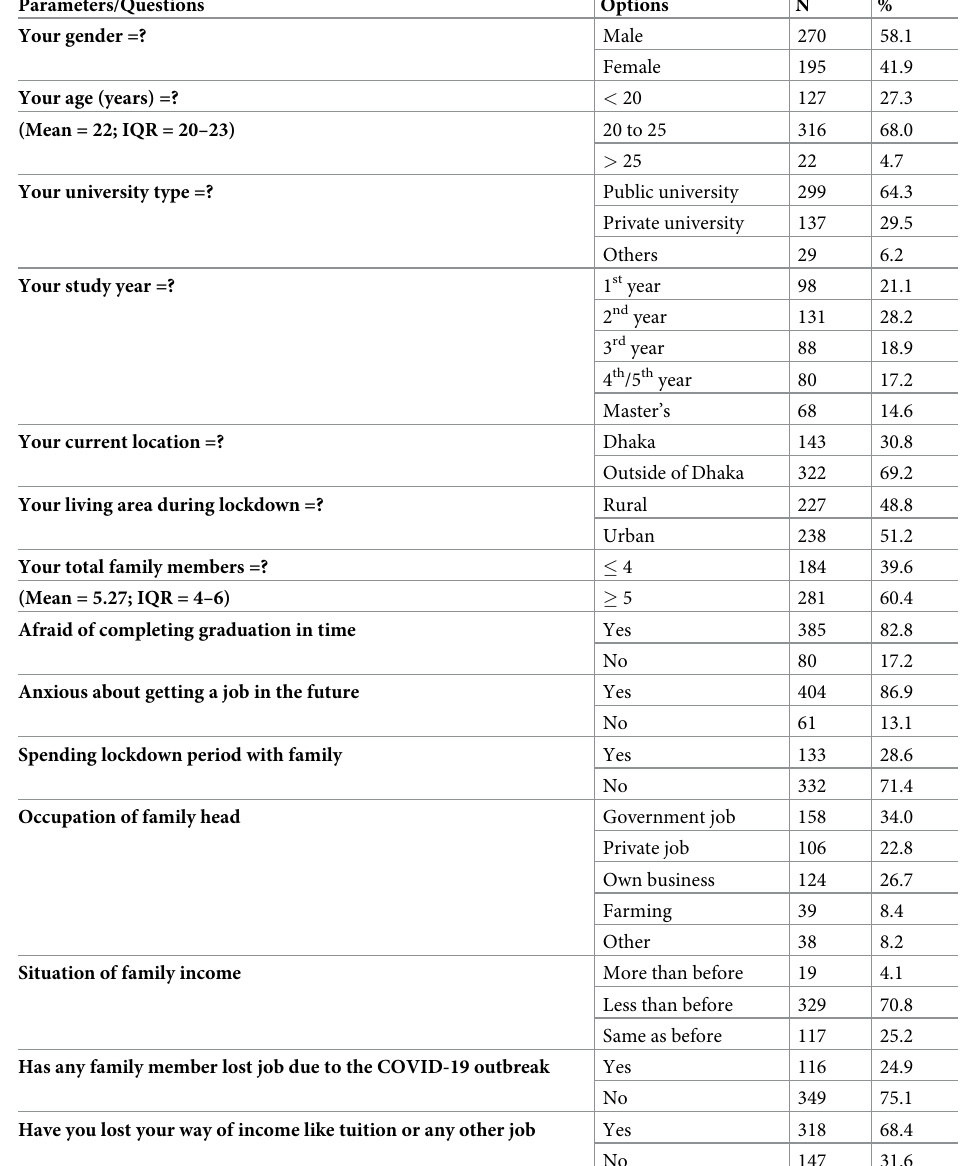
Table 1. Bangladeshi university students’ sociodemographic characteristics and covariates with descriptive statis- tics (N = 465).